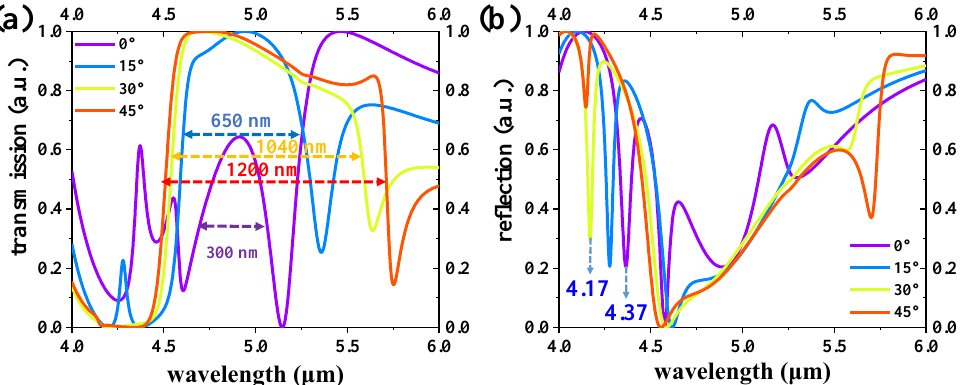
Figure 6. ( a ) Transmission and ( b ) reflection spectra of electromechanically rotatable CSM with different rotation angles under the conditions of W = 800 nm.